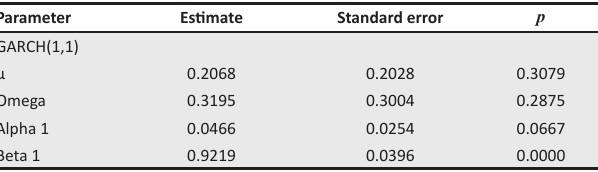
TABLE 4a: South Africa – Specification for the rate of change of forex reserves to M1 ratio: A GARCH[1,1] model. Parameter